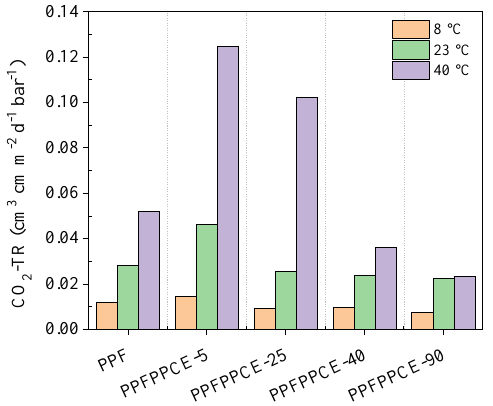
Figure 5. CO 2 -TR as a function of T (°C) for PPF and PPFPPCE-t copolymers.